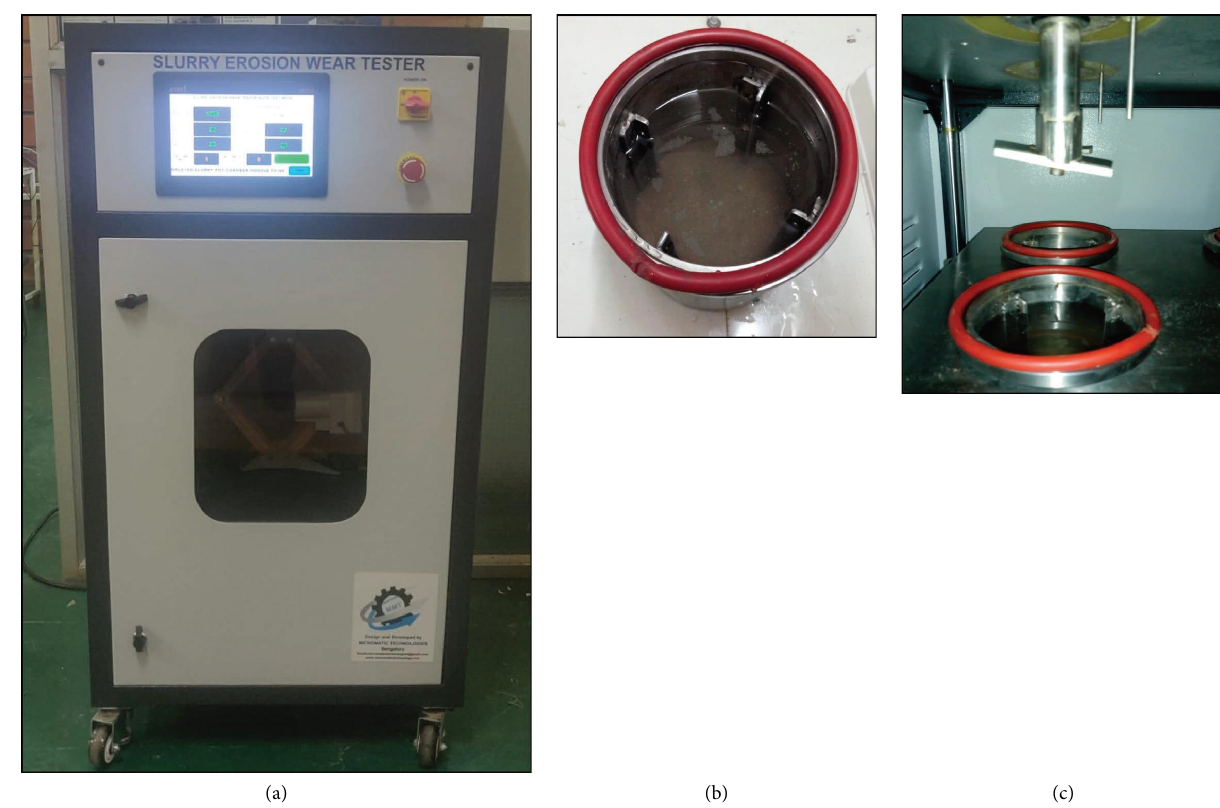
Figure 3: Slurry erosion wear test: (a) slurry erosion wear tester, (b) slurry solution, and (c) mounted test